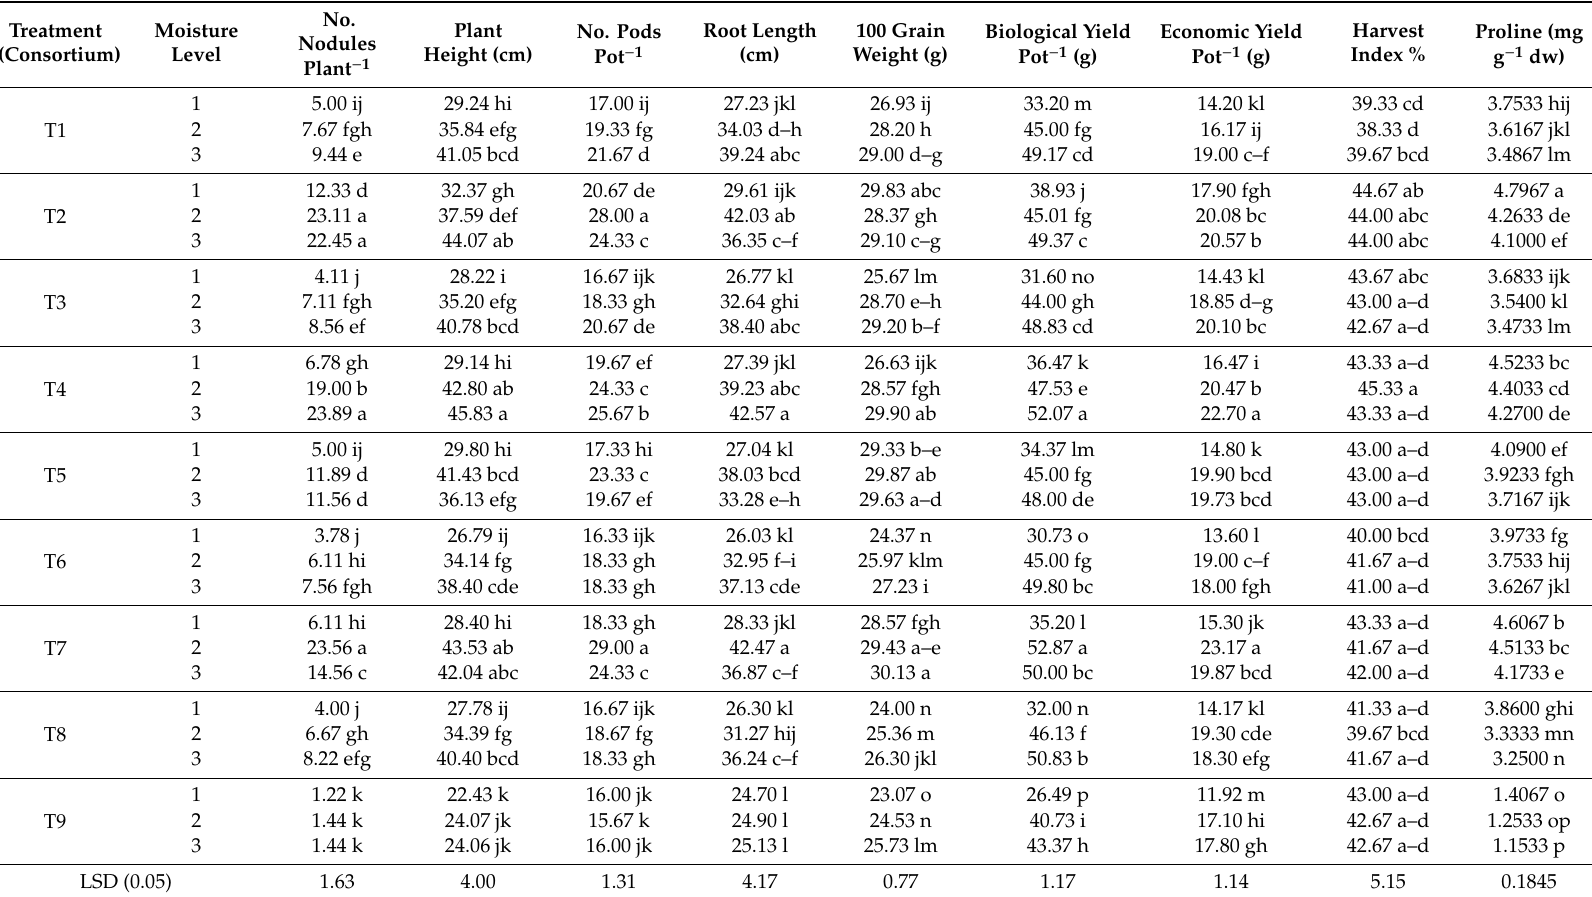
Table 4. E ff ect of inoculants on growth attributes of chickpea at di ff erent moisture